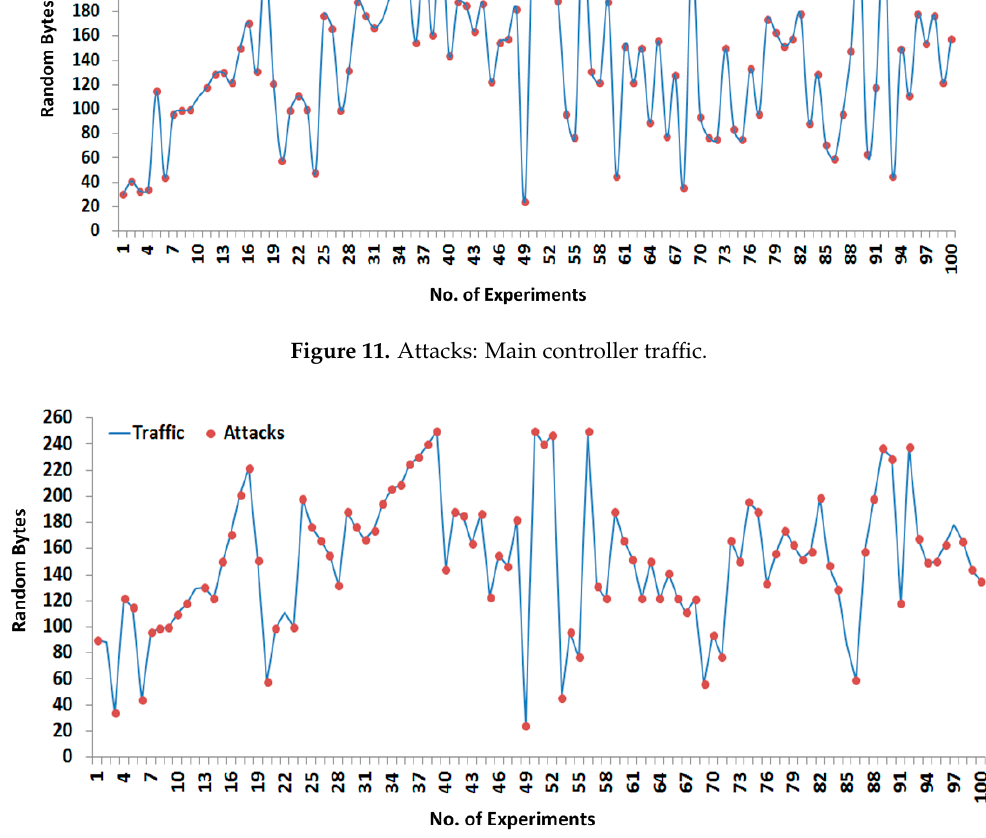
Figure 12. Attacks: Remote terminal unit traffic.